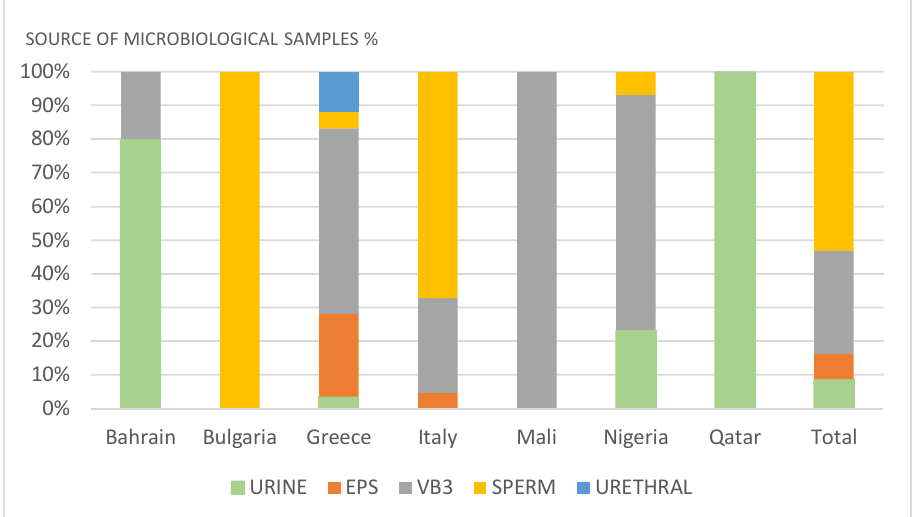
Figure 1. Source of samples for microbiological diagnosis.